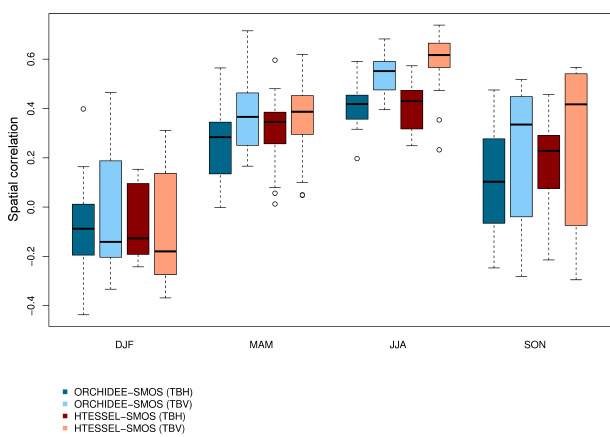
Figure 2. Boxplot showing the annual cycle of the spatial correla- tion between modelled and measured TBs over the Iberian Penin- sula from 2010 to 2012. TBH and TBV correspond to the horizontal and vertical polarizations, respectively. Values have been grouped per season: winter (DJF), spring (MAM), summer (JJA), and au- tumn (SON). Table 5. Spatial correlation for the first and second variation modes of the EOF analyses performed for the difference between modelled and measured TBs. TBH and TBV correspond to the horizontal and vertical polarizations, respectively. Mode 1 Mode 2 TB OR − TB SM (TBH) vs. 0.99